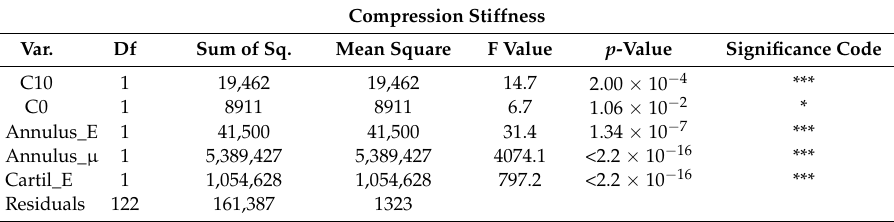
Table 14. ANOVA table for a compression stiffness linear